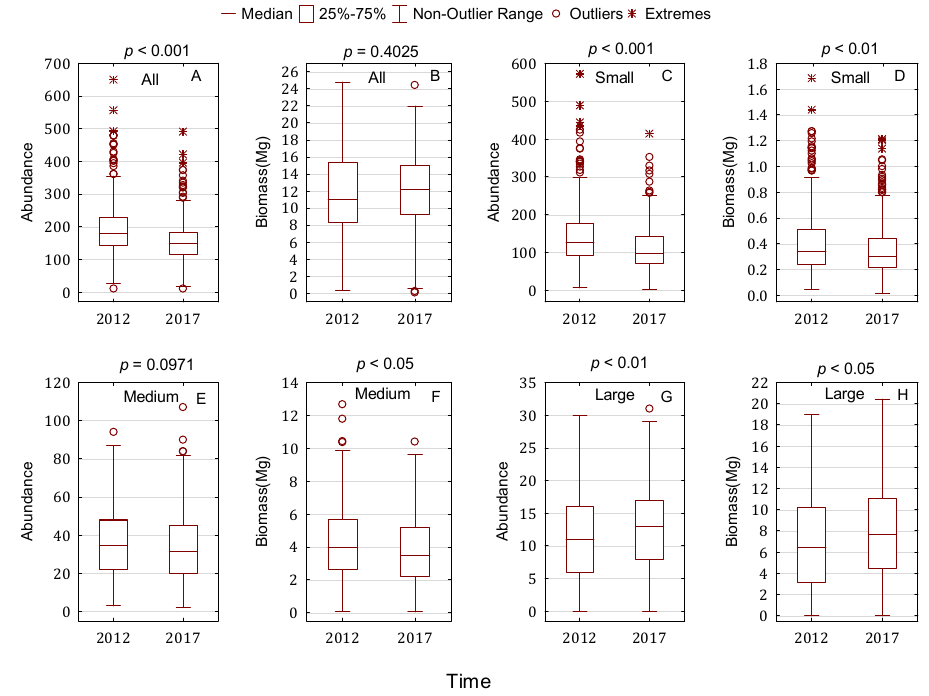
Figure 5. Changes in community biomass parameters in relation to forest succession. DBH classes are defined according to the tree size, as follows: All ( A and B ), All trees; Small ( C and D ), 1 cm ≤ DBH < 7.5 cm; Medium ( E and F ), 7.5 cm ≤ DBH < 22.5 cm; Large ( G and H ), 22.5 cm ≤ DBH.